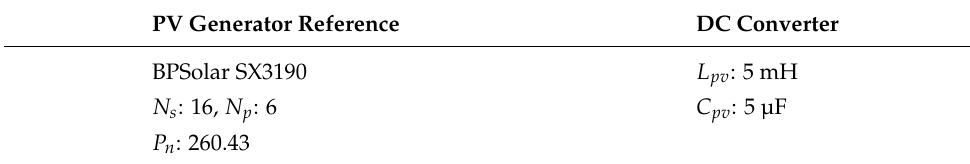
Table 3. PV generator parameters.